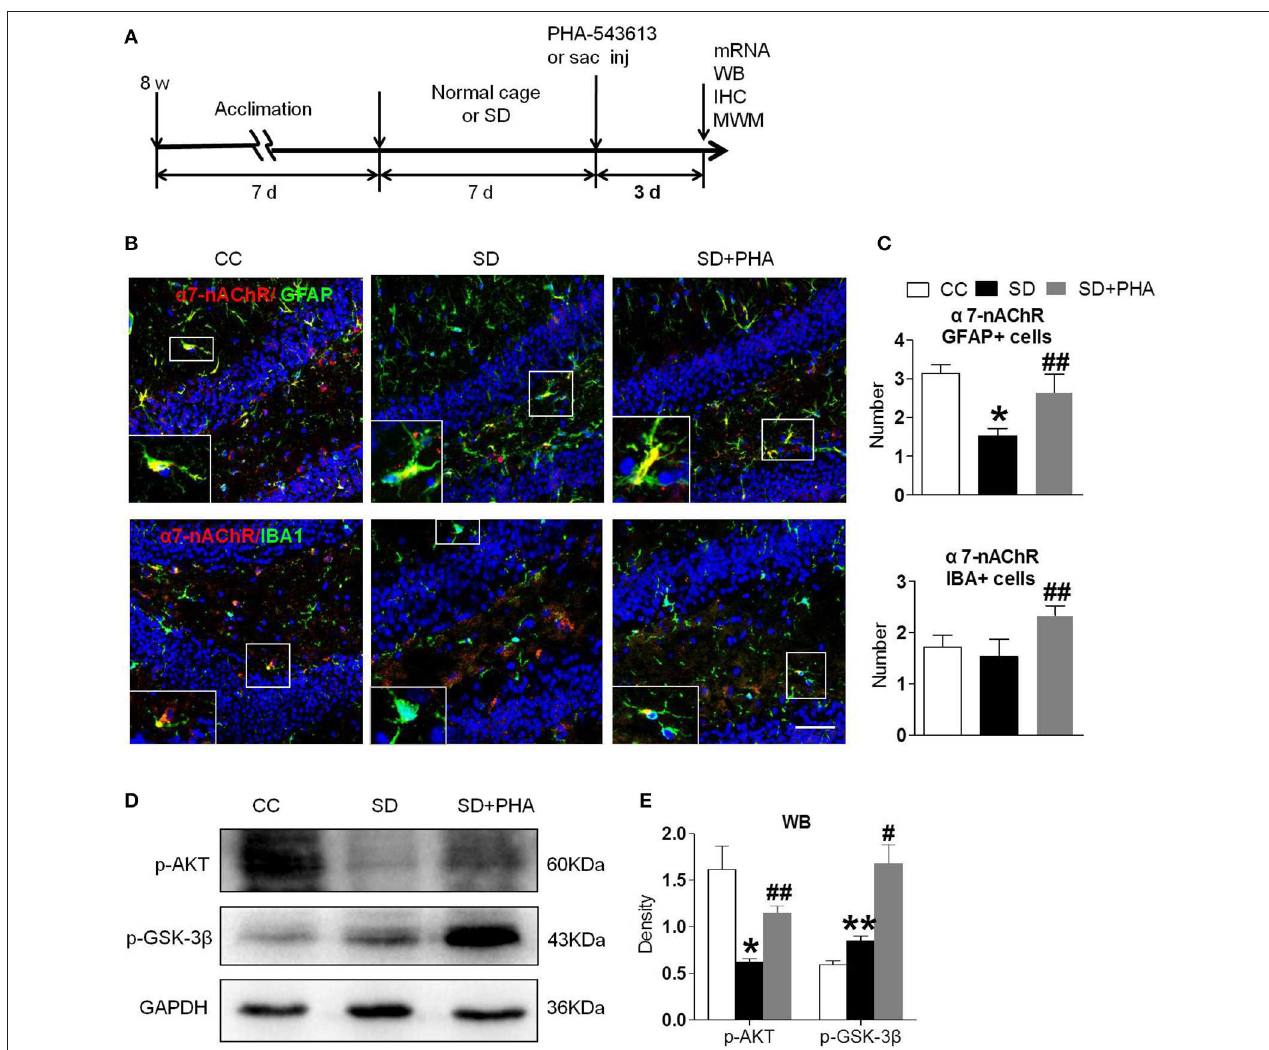
FIGURE 3 | Agonist of α 7-nAChR up-regulated expression of α 7-nAChR on glial cells and activated PI3K/AKT/GSK-3 β in hippocampus. (A) Schematic diagram depicting the experimental procedures. Before sleep deprivation, the mice in SD group was adapted to the environment in the modified multiple platforms for 7 days, 2h per day. After sleep deprivation 7 days, PHA-543613 or salin was administrated at 6 mg/kg by intraperitoneal injection immediately 6h after chronic sleep deprivation, and it was given 3 consecutive days until the experiment ended. All mice were housed with 12h light/dark cycles during the experiment and were operated on after sleep deprivation at 9a.m. (B,C) Immunofluorescent staining show counts of α 7-nAChR/GFAP + cells and α 7-nAChR/IBA + cells in the hippocampus after PHA-543613 treatment in chronic sleep deprivation. After administration of PHA-543613 for 3 consecutive days, a significant increase in α 7-nAChR/GFAP + cells was observed, the α 7-nAChR/IBA + cells were also increased, but it had no significant difference. (D,E) Western blot show the expression of p-AKT, p-GSK-3 β . The expression of p-AKT, p-GSK-3 β were increased after PHA-543613 treatment for 3 consecutive days. Data are expressed as means ± SEM,* P < 0.05, ** P < 0.01, vs. control group, # P < 0.05, ## P < 0.01, vs. SD + PHA-543613 group. CC, Cage control; SD, sleep deprivation; SD + PHA, intraperitoneal (i.p.) administration of α 7-nAChR agonist PHA-543613 (6 mg/kg) after chronic sleep deprivation for 7